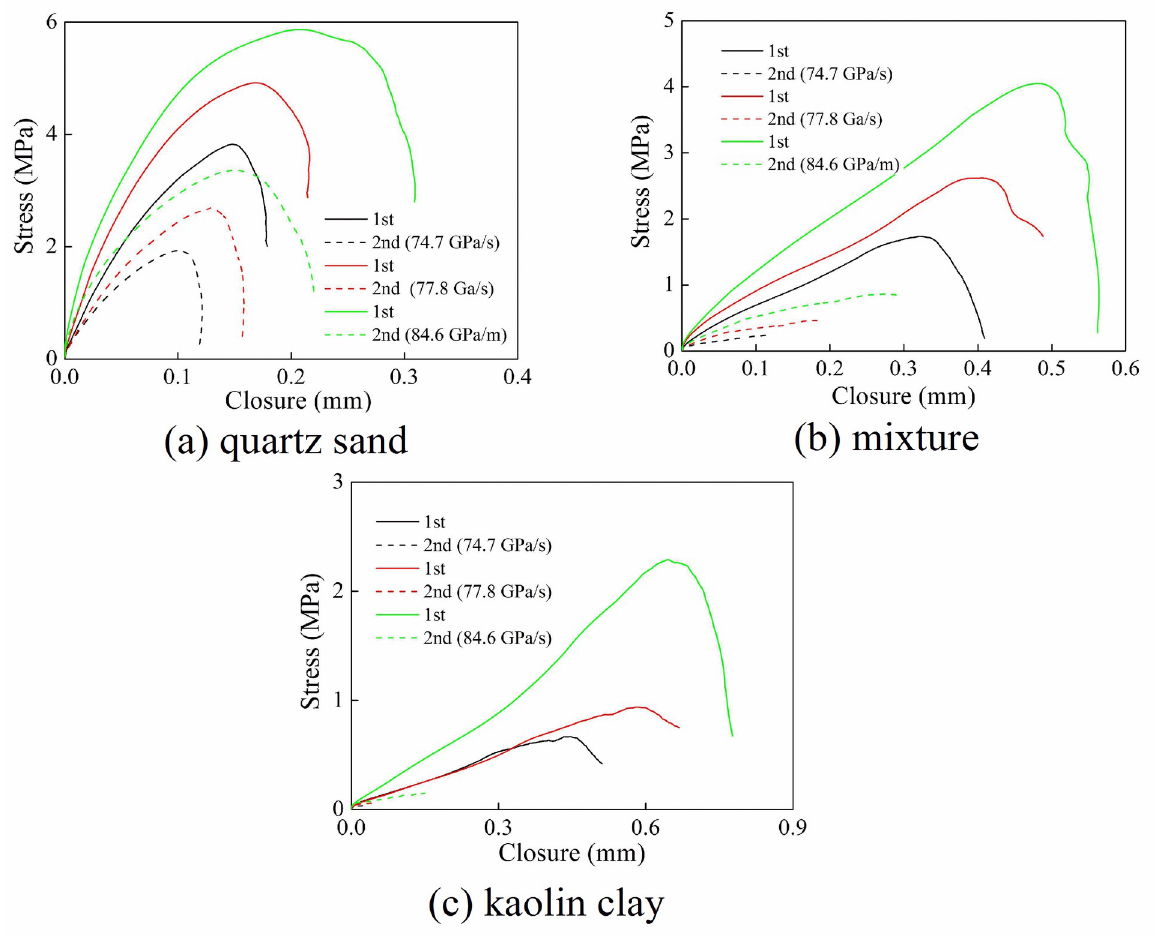
Fig 16. Stress-closure relationship of filled joints with various loading rates. (a) quartz sand (b) mixture (c) kaolin